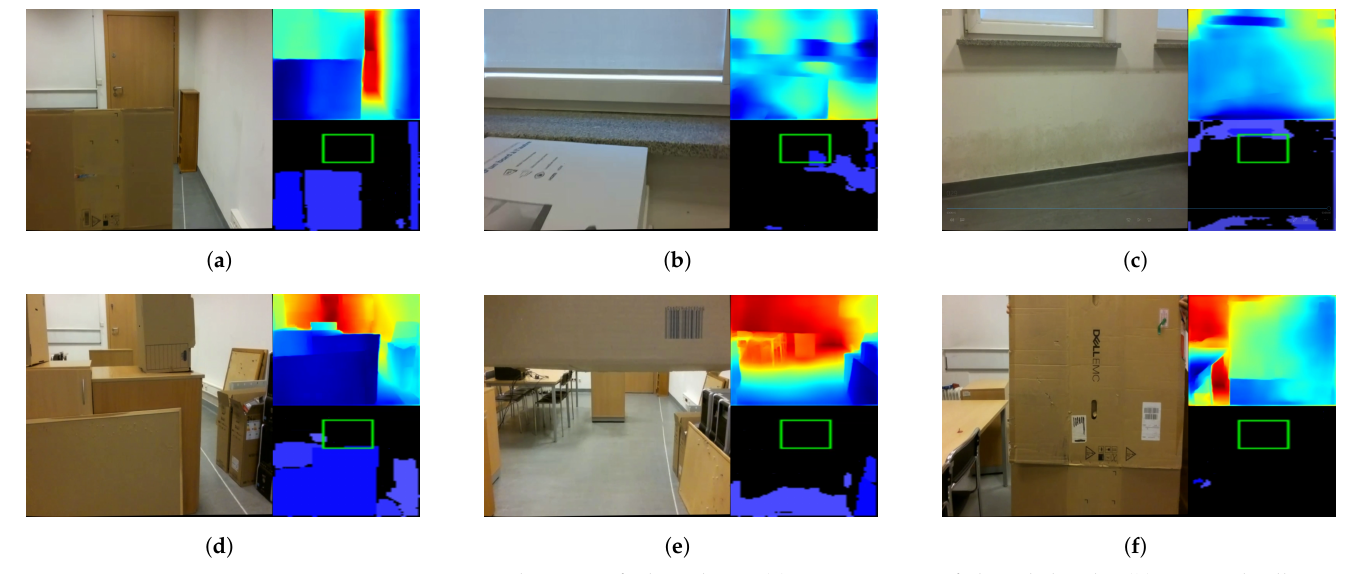
Figure 6. Example errors of Algorithm 1. ( a ) Misestimation of obstacle height. ( b ) Potential collision with a window. ( c ) Potential collision with a wall. ( d ) Misjudging the size of a complex obstacle. ( e ) Misjudging the distance to a dynamic obstacle from a hovering drone. ( f ) Misjudging the distance to a dynamic obstacle from a moving